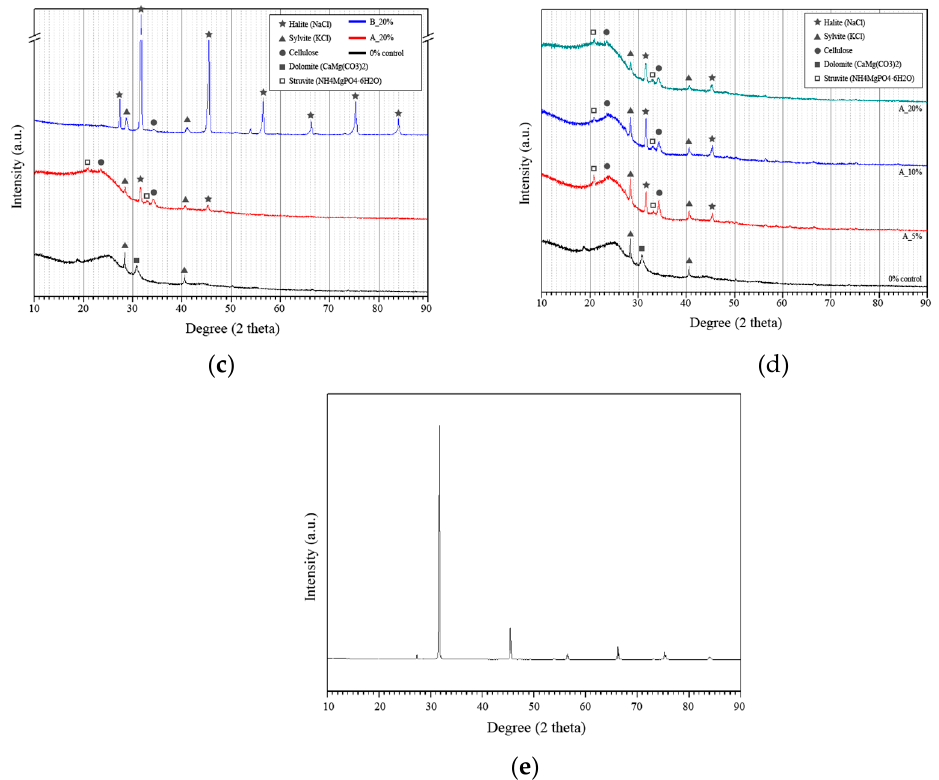
Figure 5. XRD results for ( a ) 5%, ( b ), 10%, and ( c ) 20%-NaCl biochar samples after and before washing, with 0%-NaCl biochar result. ( d ) XRD results for 0%, 5%, 10%, and 20%-NaCl samples after washing. ( e ) XRD result for NaCl powder.